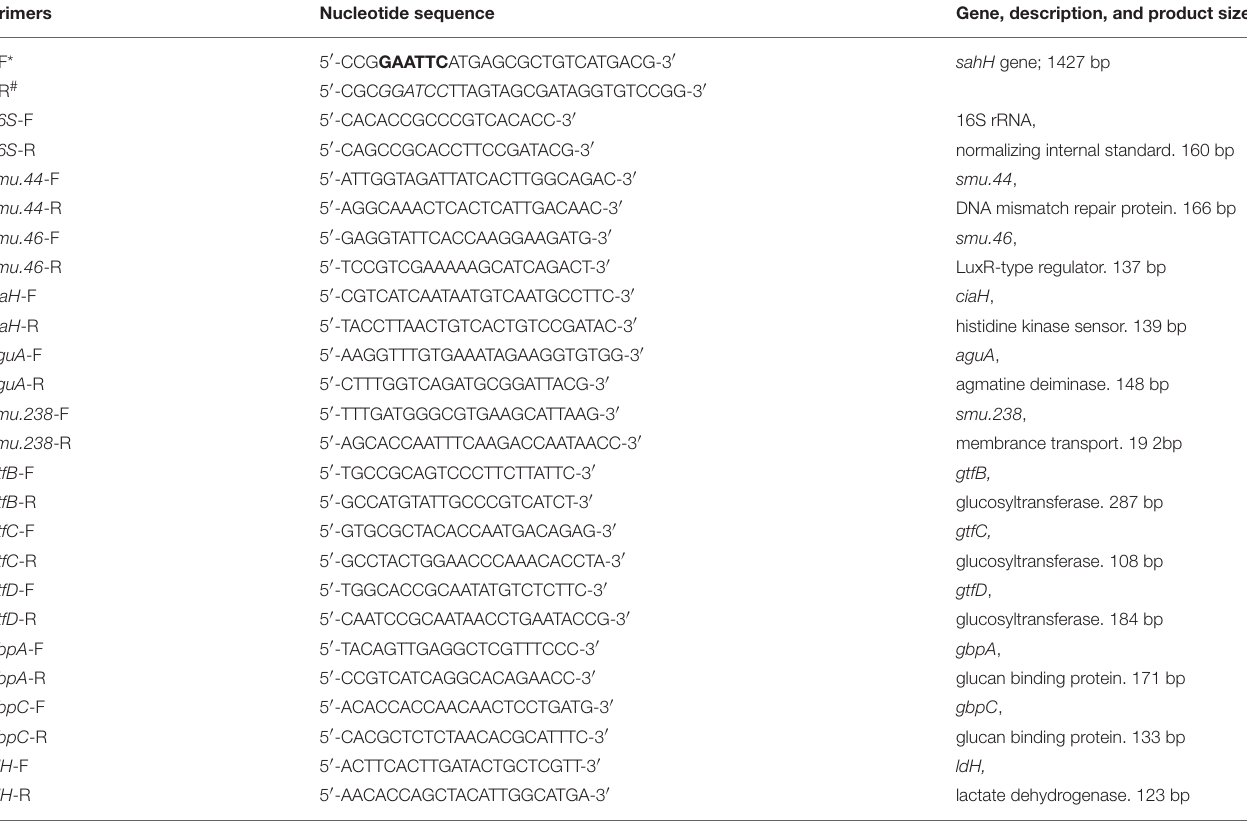
TABLE 2 | Primers used in this